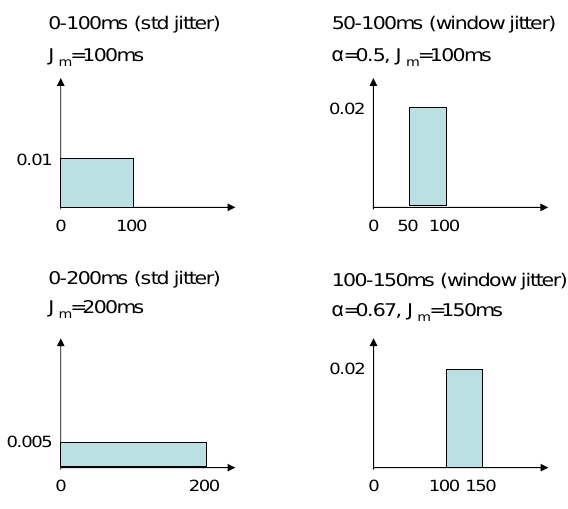
Figure 15. Pdfs for the four examined jitter